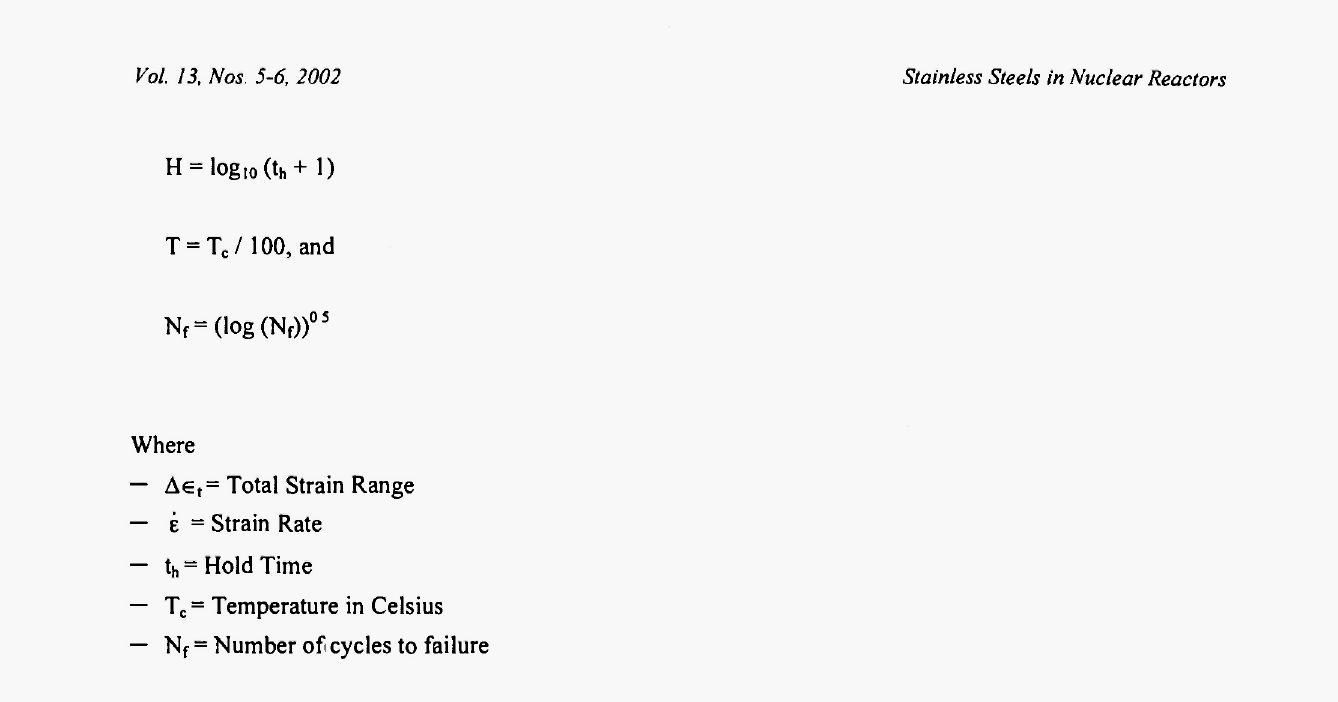
These transformations reduced the range over which the variables spanned, preventing extremely large or small values for the regression coefficients. The models obtained with these transformations were significantly higher with both Simstat and SAS. In Simstat the transformations increased the accuracy of the model by more than ten percent bringing the Multiple R-square value to 0.7515 and the Adjusted R-square value to 0.7420. The effect was even greater in the SAS model increasing the accuracy by fifteen percent with a Multiple R-square of 0.8055 and an Adjusted R-square of 0.7955. The SAS model with transformations was also analyzed using Excel; however there are more than sixteen variables in the equation so Excel could not be used to validate the equation as it did the equation without transformations.